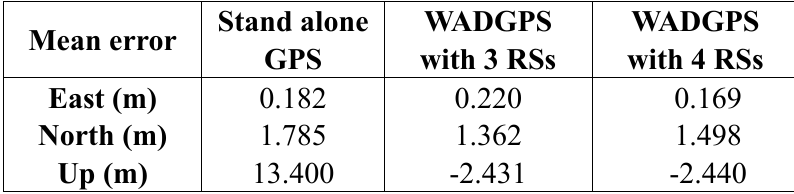
Table 5. Mean of positioning error (Taipei FIR).